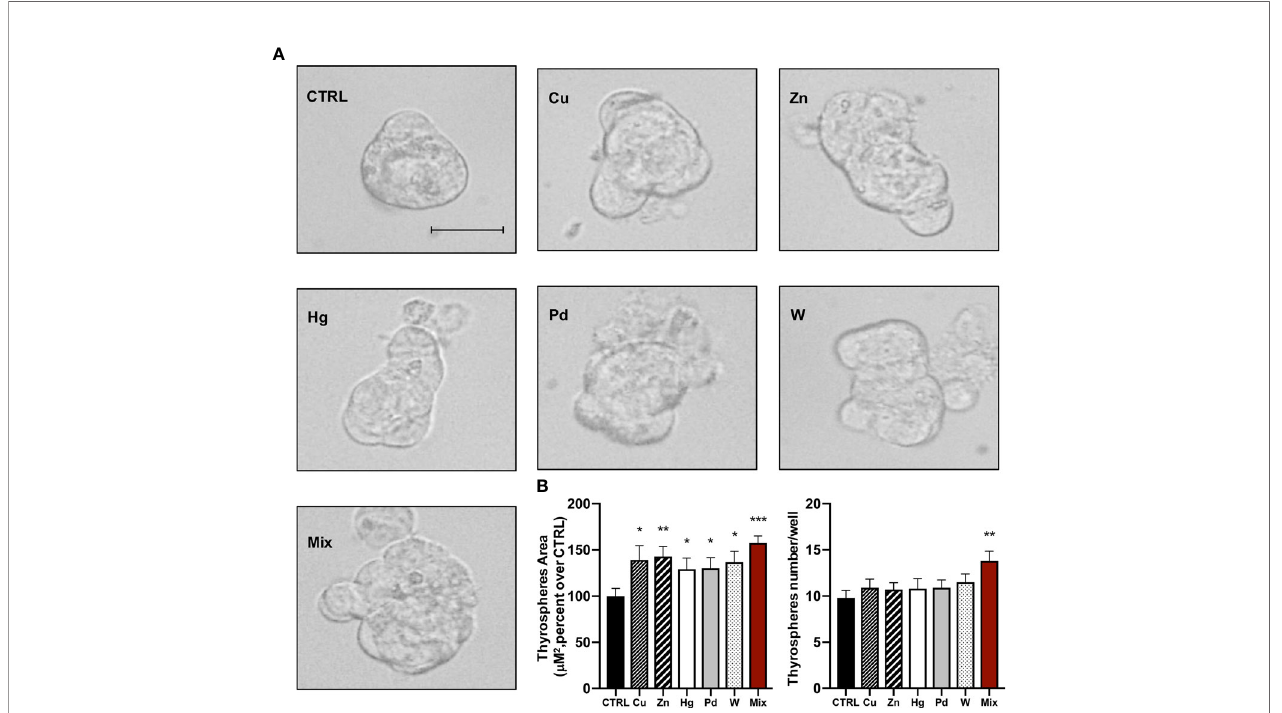
FIGURE 2 | (A) Representative phase – contrast microscopy images of thyrospheres grown in standard medium (CTRL) or in medium added with each of the fi ve heavy metals tested (at the salt concentration causing the maximum BrdU incorporation) or their mixture for 8 days (Scale bar: 30 m M). (B) Histograms indicate the mean value ± SEM of three separate experiments for measuring the size ( m M 2 ) and the number of thyrospheres after exposure to each metal or their mixture. *p < 0.05, **p < 0.01, ***p < 0.001 vs.